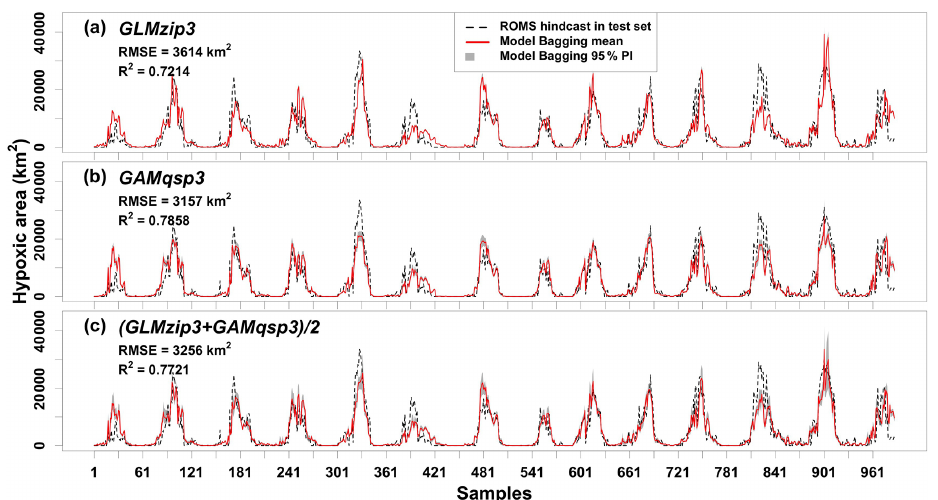
Figure 4. Comparisons of model-predicted HA and ROMS-hindcast HA in the test set. RMSEs and R 2 s are derived between the model bagging mean and ROMS-hindcast